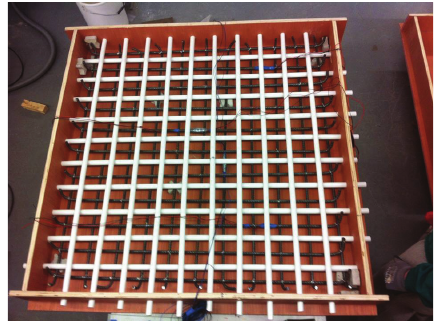
Figure 11: PVC duct locations prior to casting.